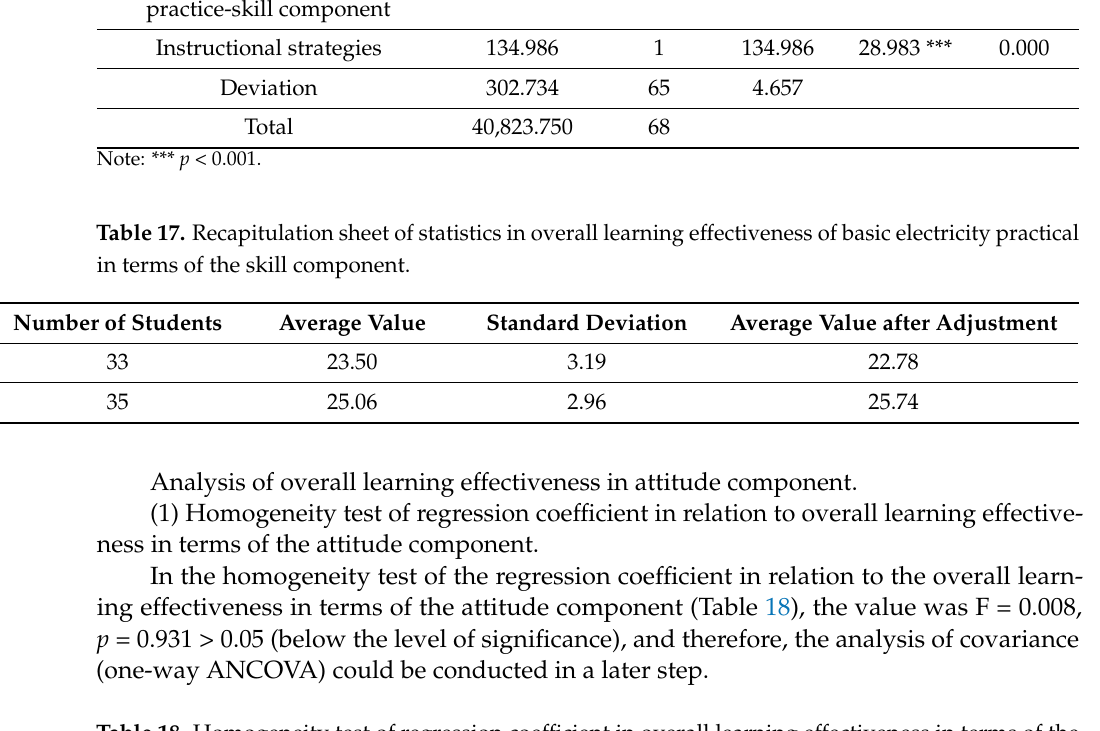
Table 18. Homogeneity test of regression coefficient in overall learning effectiveness in terms of the attitude